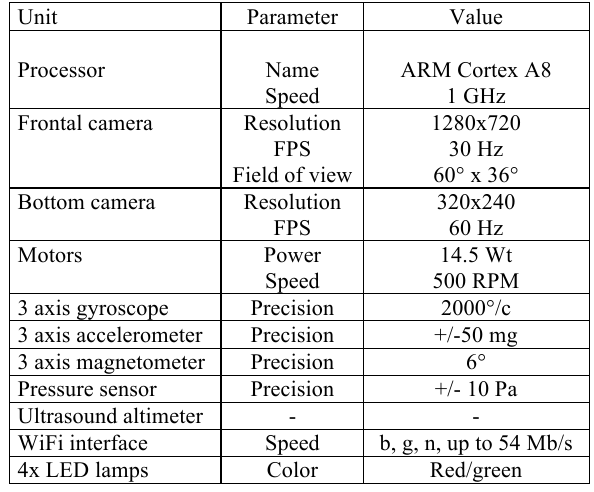
Table 2. Technical specifications of AR.Drone 2.0 UAV